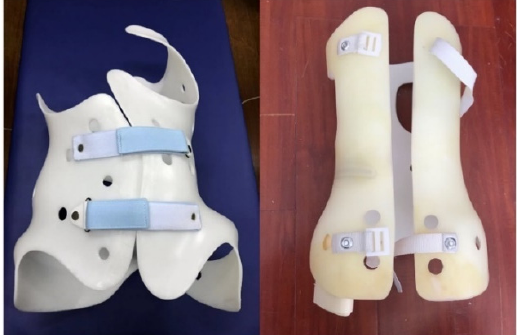
Figure 1. Adjusted Cheneau brace ( left ) and Boston brace ( right ) used by